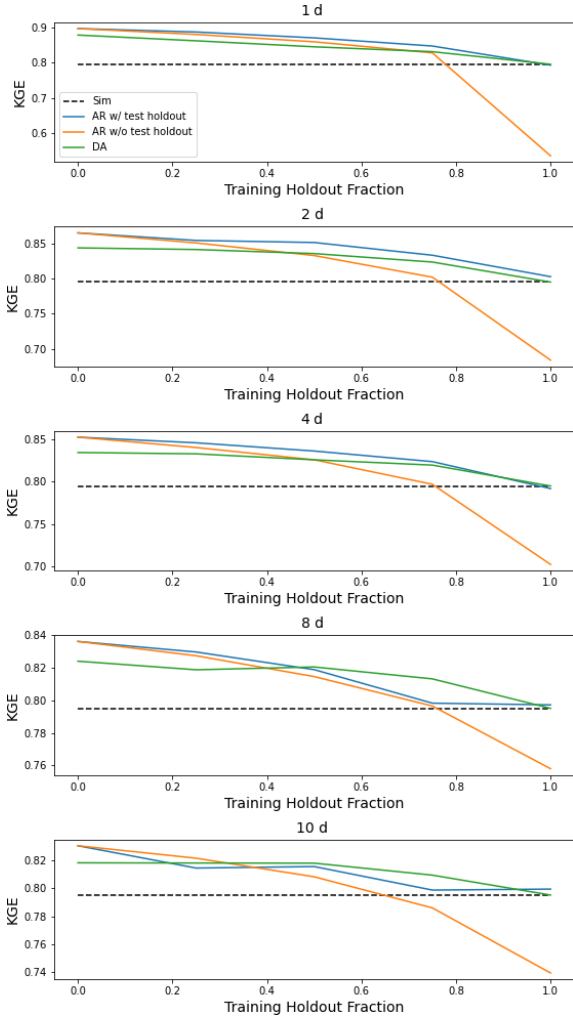
Figure H1. Same as Fig. 4 but for Kling–Gupta efficiency. Figure H2. Same as Fig. 4 but for the Pearson correlation coeffi-